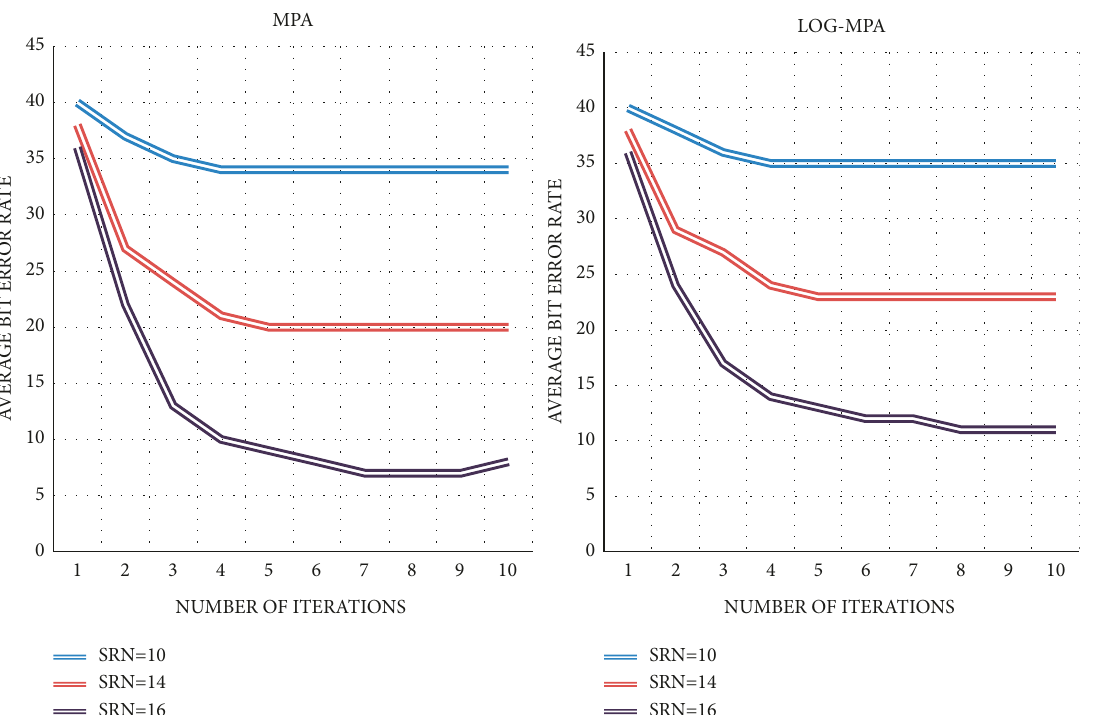
Figure 14: Comparison of convergence speed of different decoding algorithms under SCMA